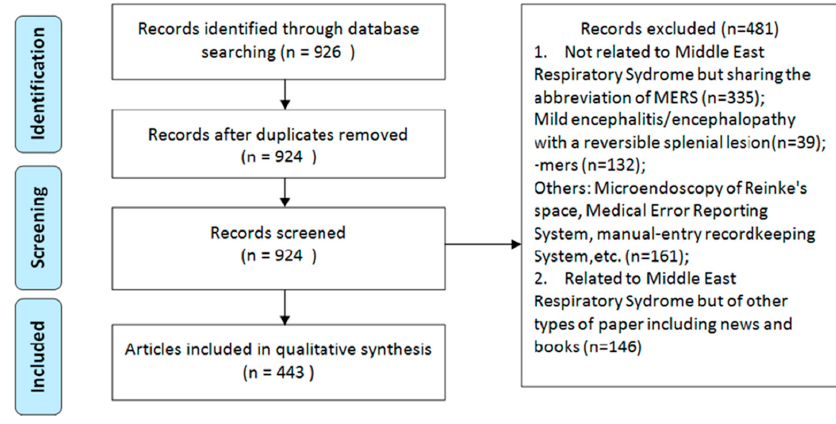
Figure 1. Flowchart. Figure 1.